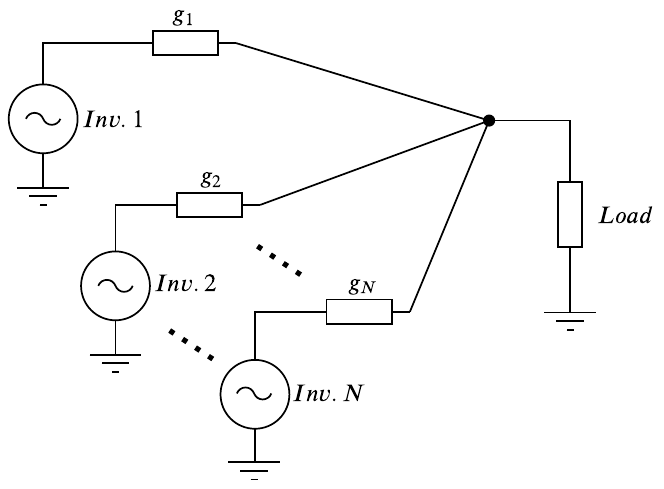
Figure 1. Interconnected system with N